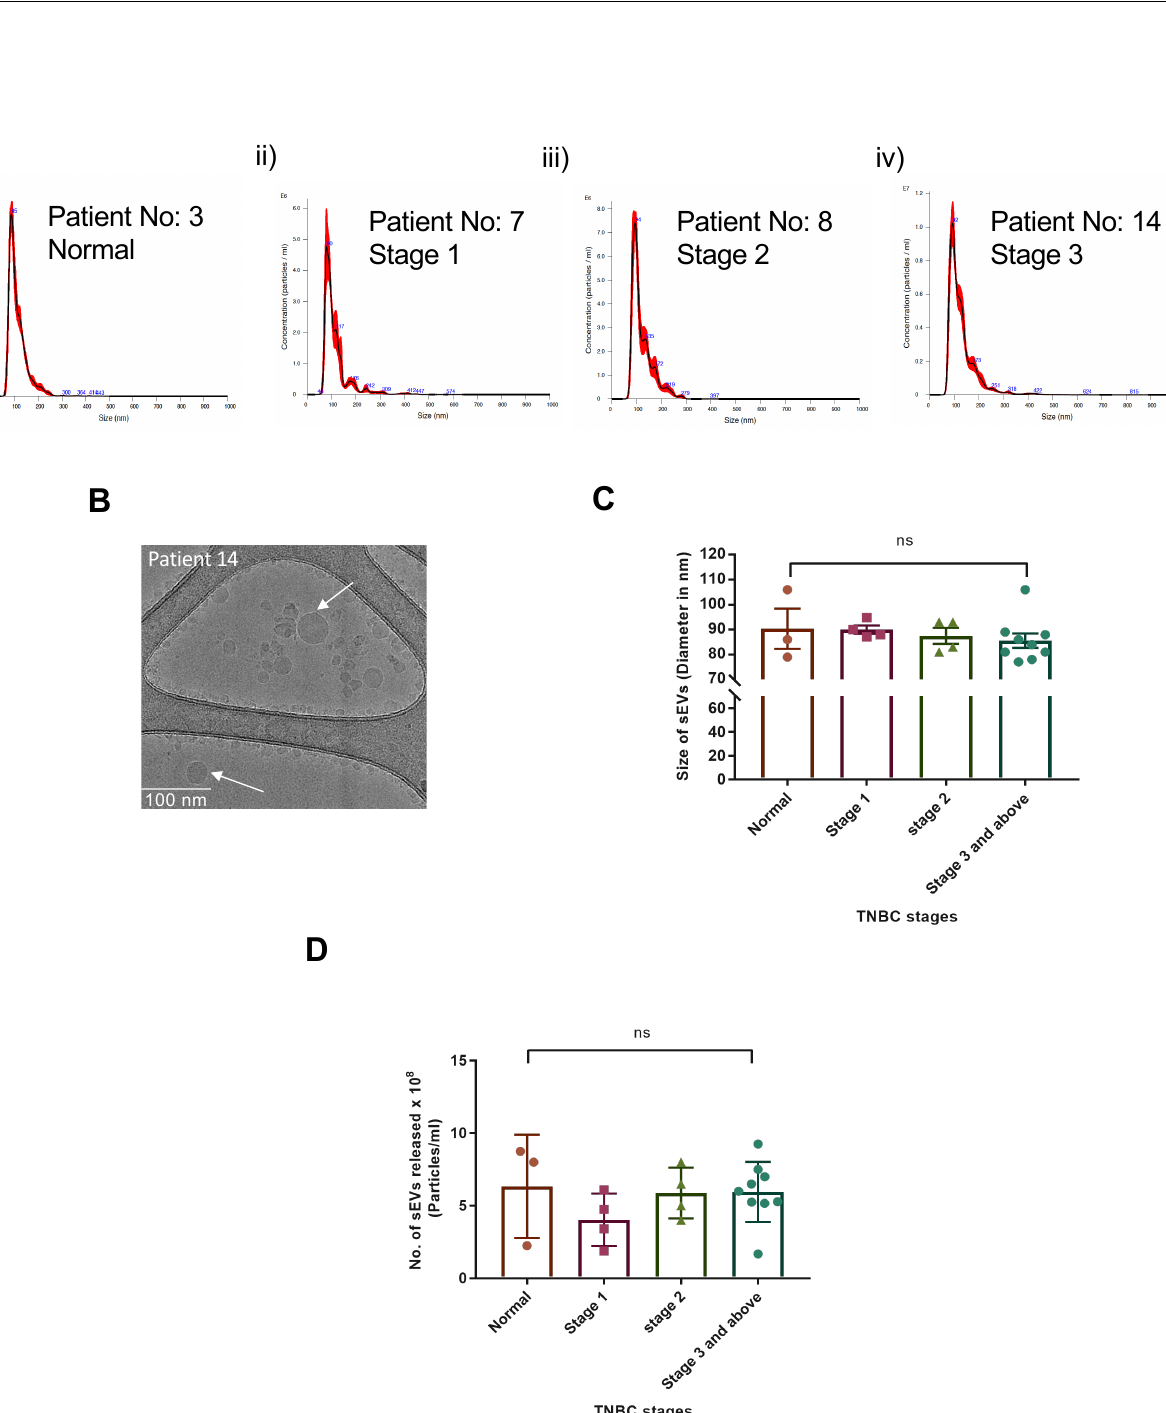
Figure 2. No significant change in sEV sizes and release in patient serum samples of different TNBC stages. ( A ). NTA analysis of Normal and TNBC stage 1, 2, 3 and above patient serum-derived sEV samples isolated by ExoQuick Ultra kit after IgG depletion. ( B ). Cryo-TEM image of TNBC patient serum-derived sEVs. ( C ). Graphical representation shows the comparison of the means of sEV sizes isolated from the patient of each TNBC stage. ( D ). Graphical representation shows the comparison of the means of the number of sEVs released per ml in the 3 normal and 17 patient sera from each stage. (Mean ± SEM, n = 3 for normal samples, n = 4 for stage 1, n = 4 for stage 2, and n = 9 for stage 3 and